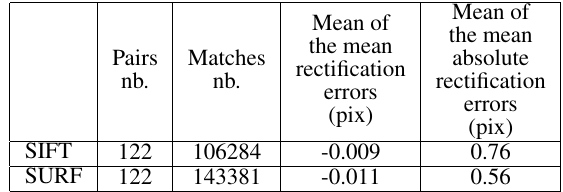
Table 1. Rectification errors (in pixels) computed using SIFT or SURF matches over 122 stereo-rectified images pairs, generated from Track3 US3D sensor imagery pairs and lidar by our ground truth pipeline. Figure 4. Histograms of median absolute rectification errors (in pixels), using SIFT on the left, and SURF on the right, over the same 122 pairs as in Tab.